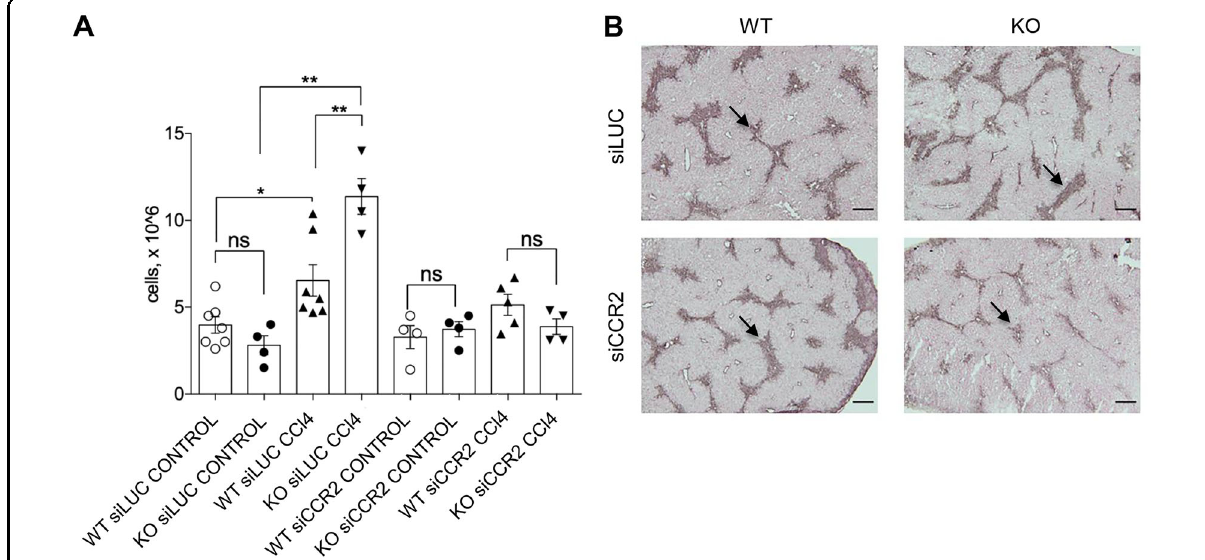
Fig. 6 Silencing CCR2 reverts enhanced leukocyte in fi ltration in GILZ KO mouse livers. A The number of leukocytes isolated from the livers of 4-month-old WT and GILZ KO mice that had been pretreated with siCCR2 or siLUC (LUC) for 1 week and then treated with oil (control) or CCl 4 for 72 h. B Immunohistochemical analysis of α -SMA expression in the liver sections of WT and GILZ KO mice that had been pretreated with siLUC or siCCR2, and then treated with oil or CCl 4 for 72 h. Arrows indicate the areas of α -SMA positivity. Original magni fi cation, 5×; scale bar, 200 µM. Results are presented as the means ± SEM. Each dot represents an individual mouse; scale bars indicate the mean. Data were pooled from two independent experiments (** p < 0.005, ns not signi fi